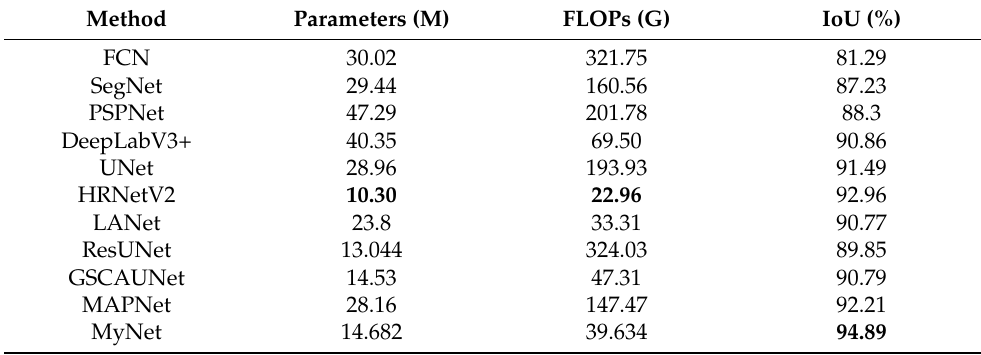
Table 7. Comparison of related algorithms on parameters, FLOPs and IoU on the AG dataset. The fewest parameters, smallest FLOPs and highest IoU are marked in